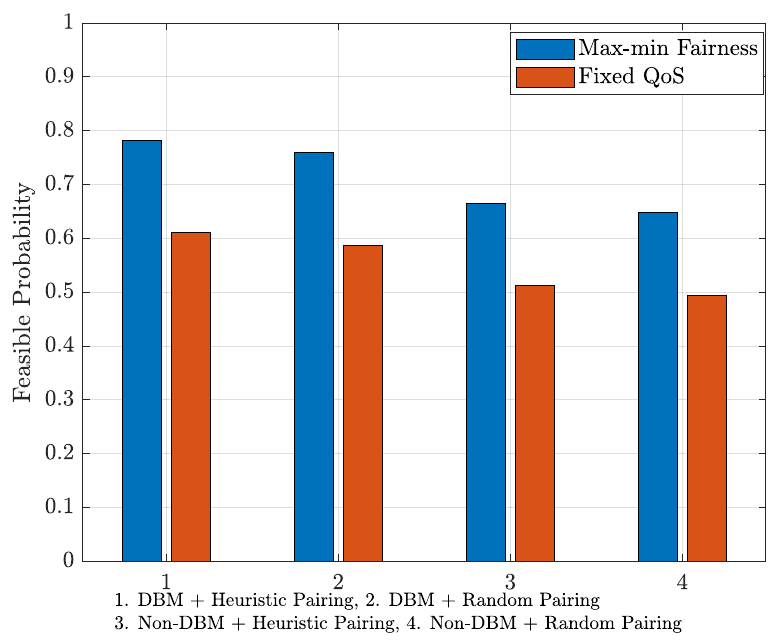
Figure 6. The feasible probability of the different benchmarks with the QoS 1.5